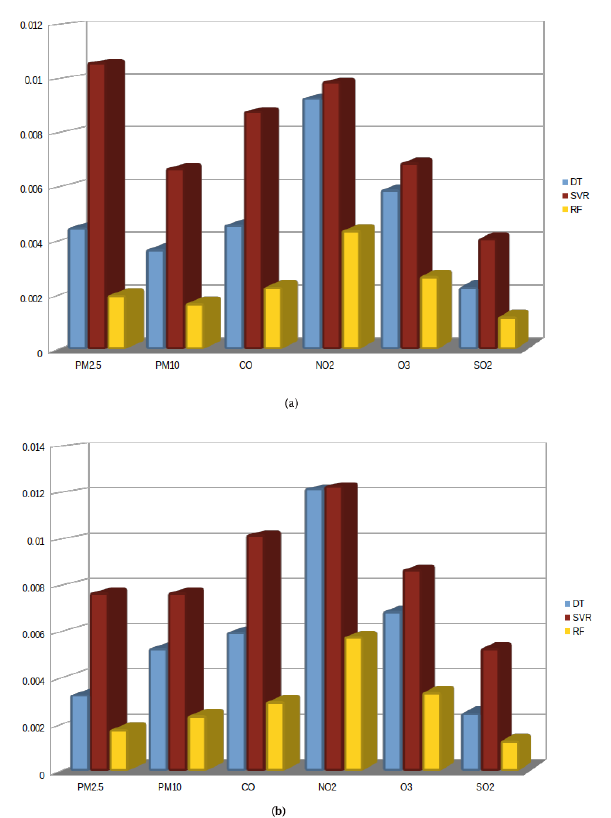
Figure 3. Visualization of MSE results obtained in all experiments, (a) for Guanyuan City Weather Station Data, and (b) for Wanshouxigong Weather Station